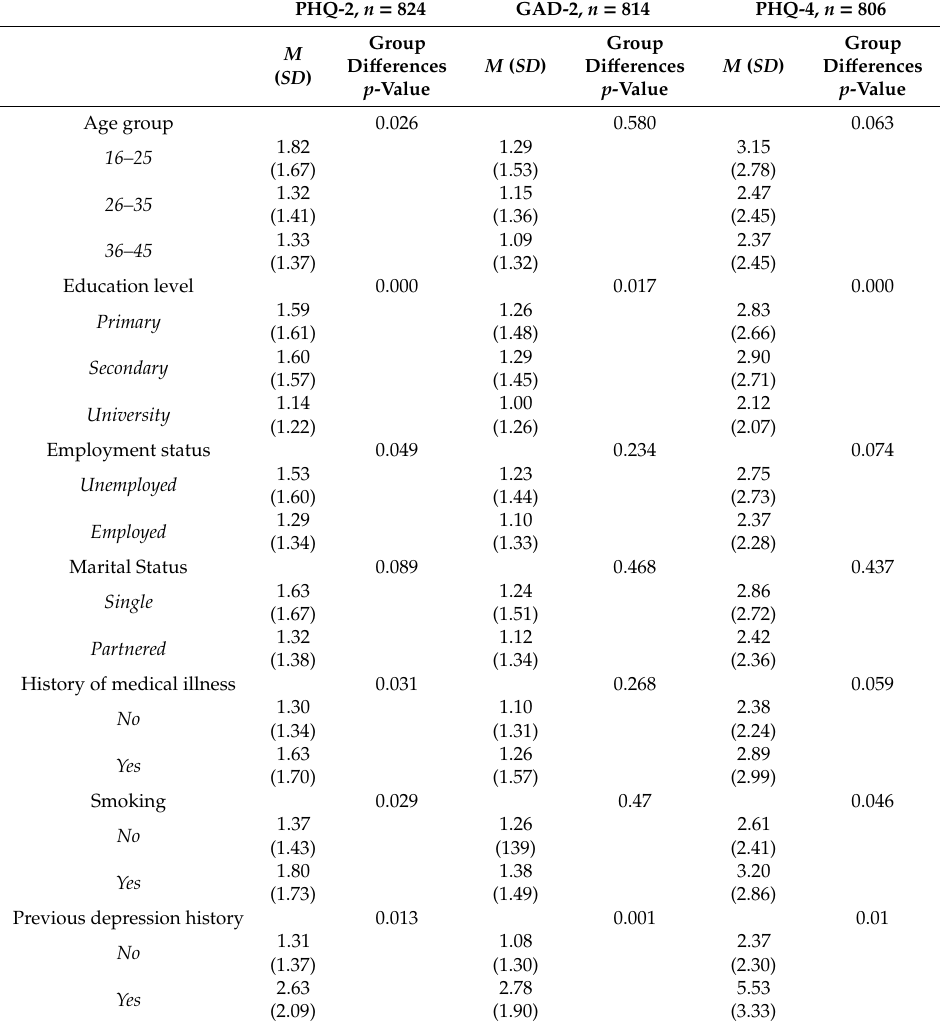
Table 5. Association of the PHQ-2, the GAD-2 and the PHQ-4 with sociodemographic characteristics. PHQ-2, n = 824 GAD-2, n = 814 PHQ-4, n =